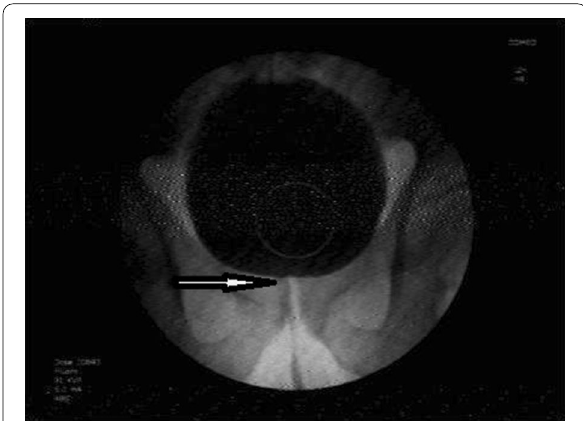
Fig.2 White arrow: floroscopic image of obstructed bladder neck during voiding phase of videourodynamic study.